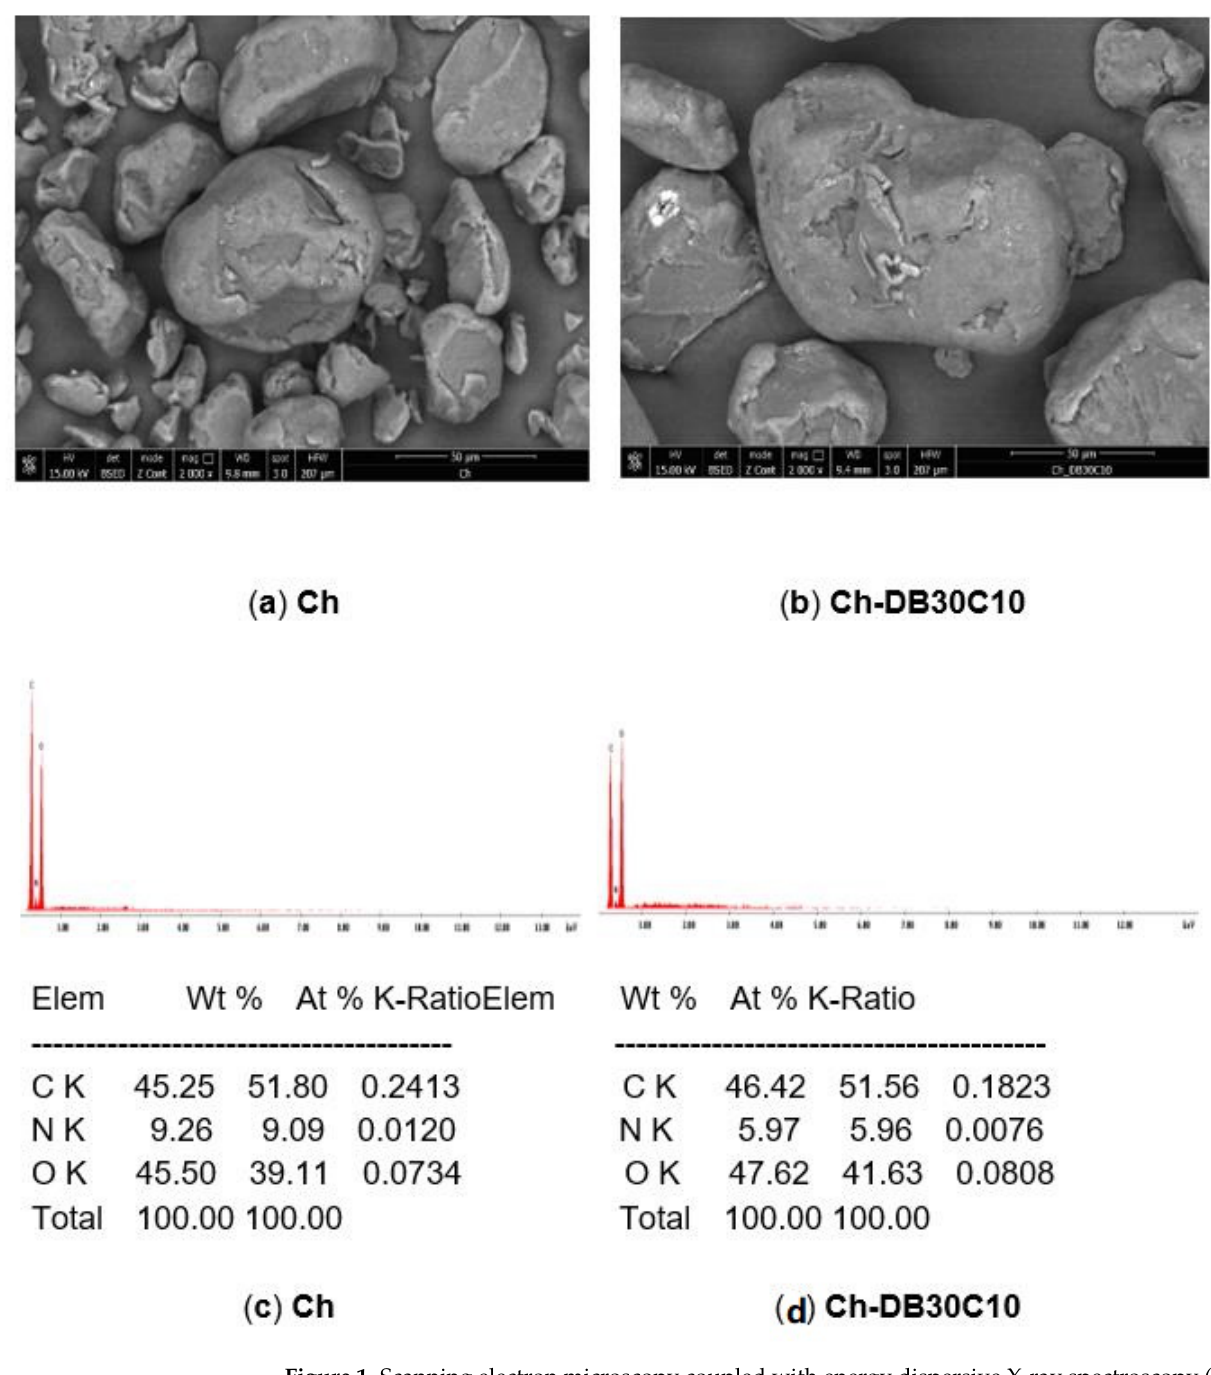
Figure 1. Scanning electron microscopy coupled with energy dispersive X-ray spectroscopy (SEM– EDX). ( a ) SEM recorded for Ch, ( b ) SEM recorded for Ch-DB30C10, ( c ) EDX spectrum recorded for Ch, ( d ) EDX spectrum recorded for